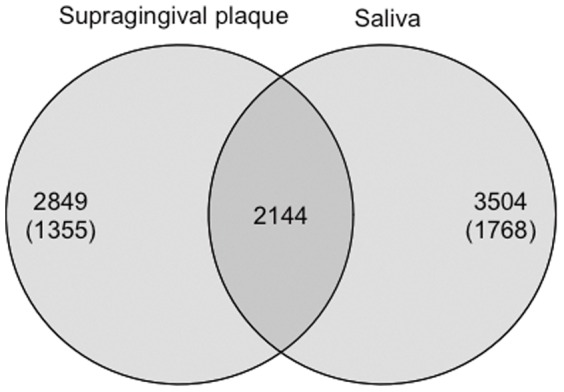
Venn diagram of the overlap between supragingival plaque observed operational taxonomic units (OTUs) vs. saliva observed OTUs.The numbers of singleton OTUs, detected from only one read from one subject, are shown in parentheses.